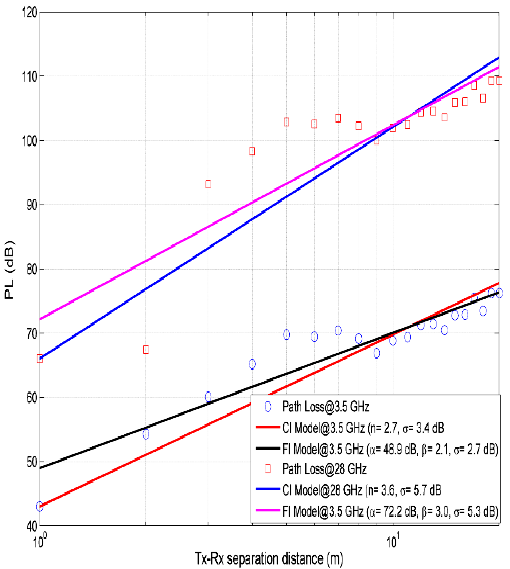
Figure 5. Path loss CI and FI models fitting versus Tx-Rx separation distance at 3.5 GHz and 28 GHz for NLOS scenario.